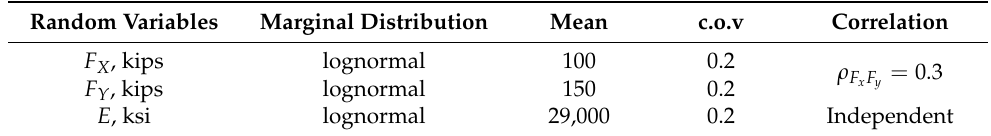
Table 3. Description of the random variables for the truss